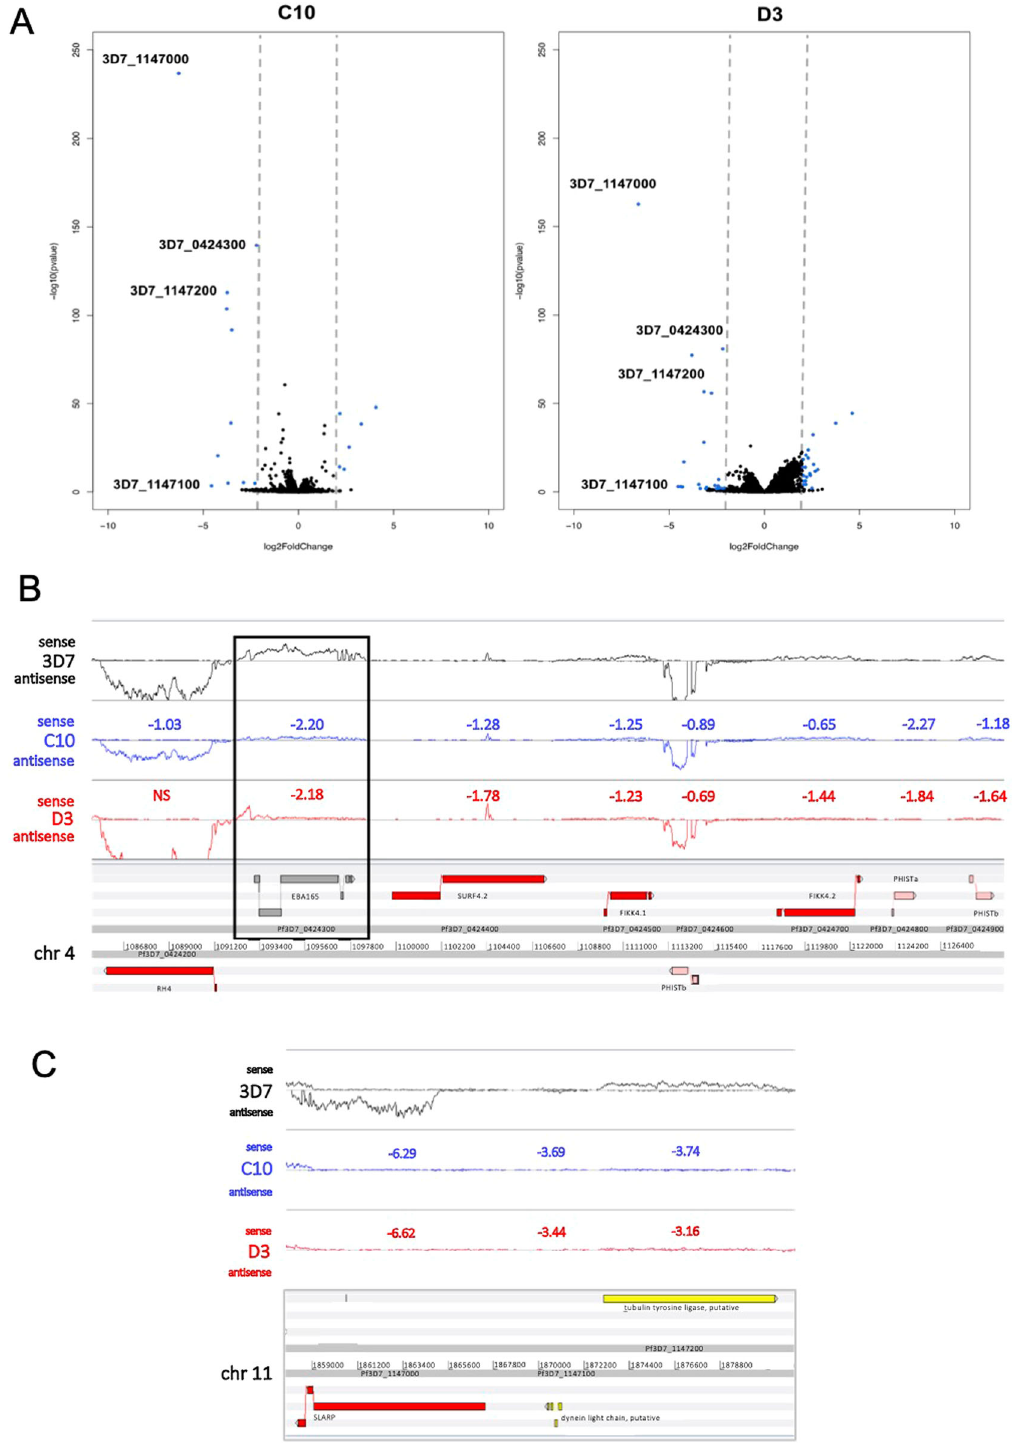
Fig. 5 PfEBA165 frameshift correction reveals clusters of down-regulated genes. a Volcano plots showing signi fi cantly upregulated and down-regulated genes in the EBA165 double-edited parasite clones C10 and D3 relative to 3D7, plotted as -log 10 (pvalue) against log 2 fold change (log 2 FC). Blue dots represent highly up-regulated and downregulated genes ( − 2 > log 2 FC > 2, adjusted p -value ≤ 0.05, DESeq2 Wald-test). Hashed lines indicate cutoffs of − 2 > log 2 FC > 2. Dots with no gene IDs listed beside them are genes belonging to gene families that are known to be clonally variant in expression. b The genomic region on chromosome 4 that is downregulated in the PfEBA165 restored lines. Log 2 fold change in expression relative to the wild-type 3D7 line is shown numerically above each gene; PfEBA165 is highlighted in the boxed region. c The genomic region on chromosome 11 that is down-regulated in the PfEBA165 corrected lines. Log 2 fold change in expression relative to the wild-type 3D7 line is shown numerically above each gene